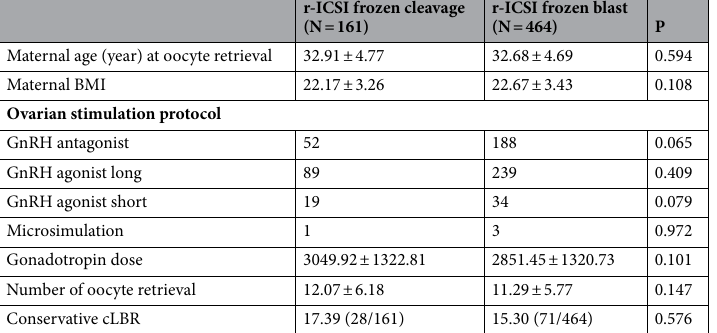
r-ICSI frozen blast (N = 464) P